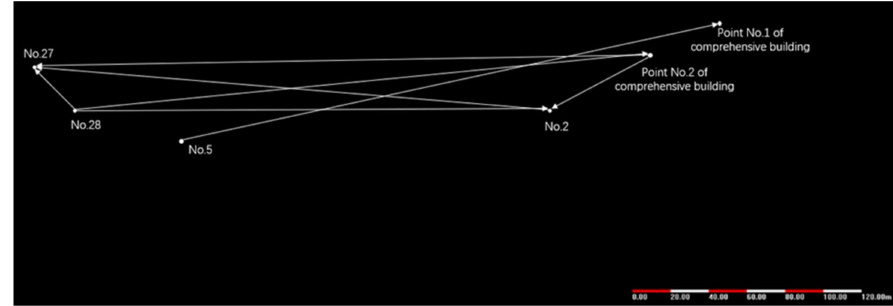
Figure 15. The interface diagram of original data import by CGO.